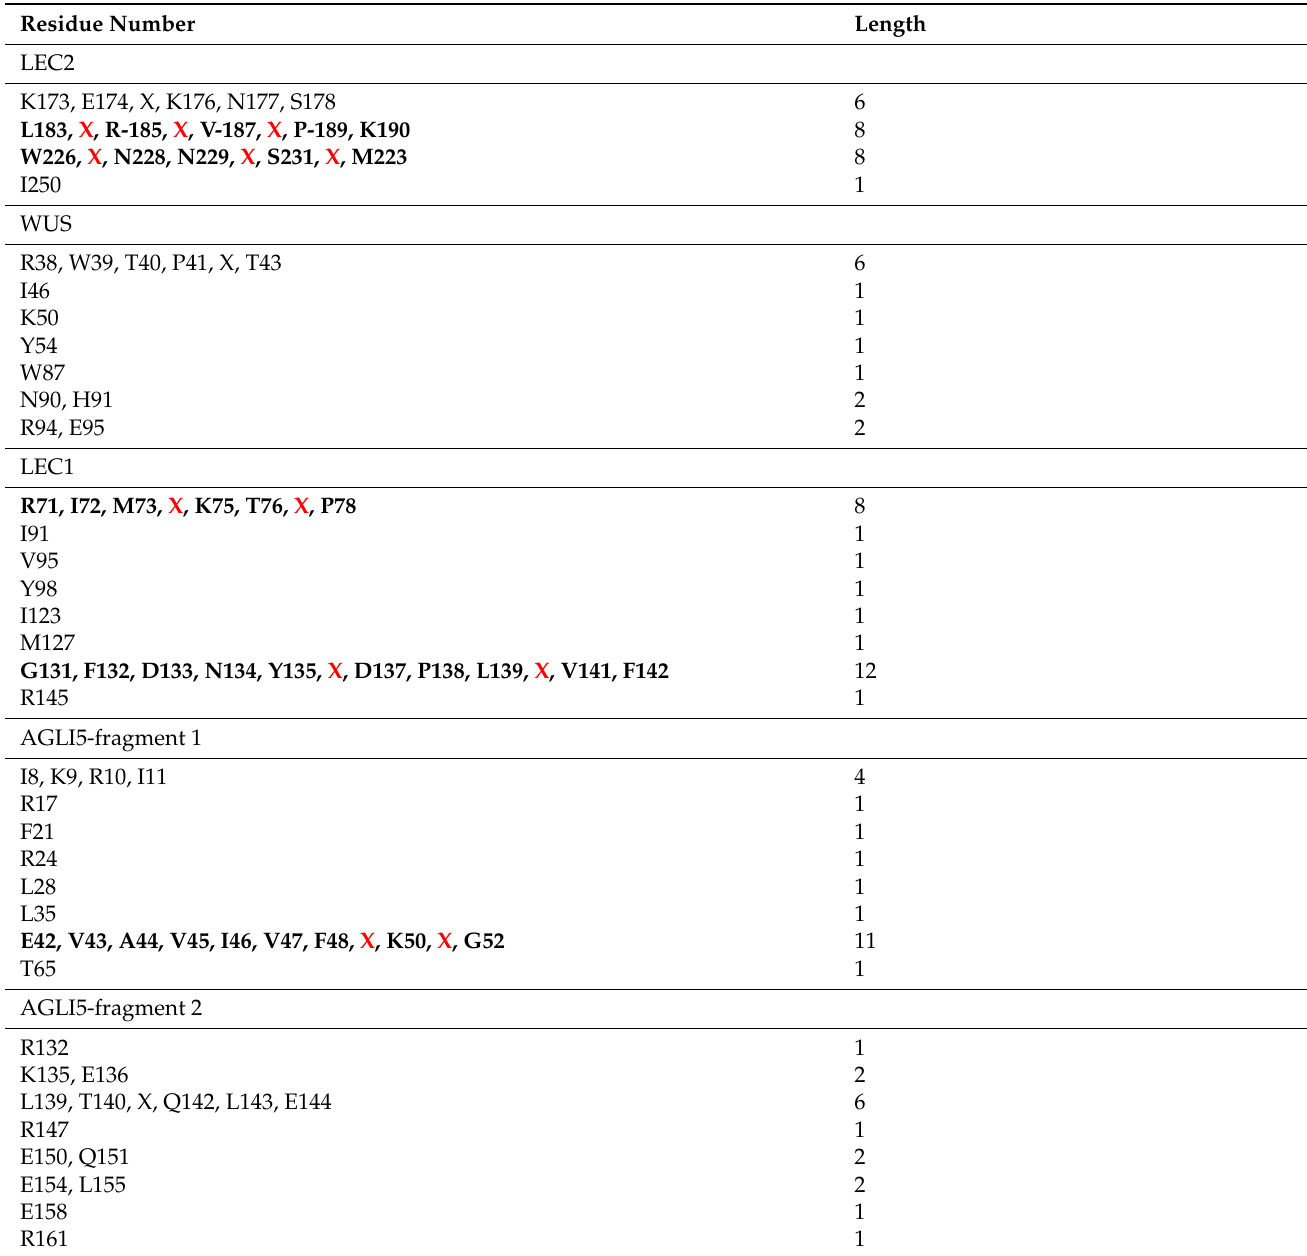
Table 4. Continuous stretches of amino acid residues of the interacting partner proteins at the interface of the BBM protein for fragment 1. Selected stretches are shown in